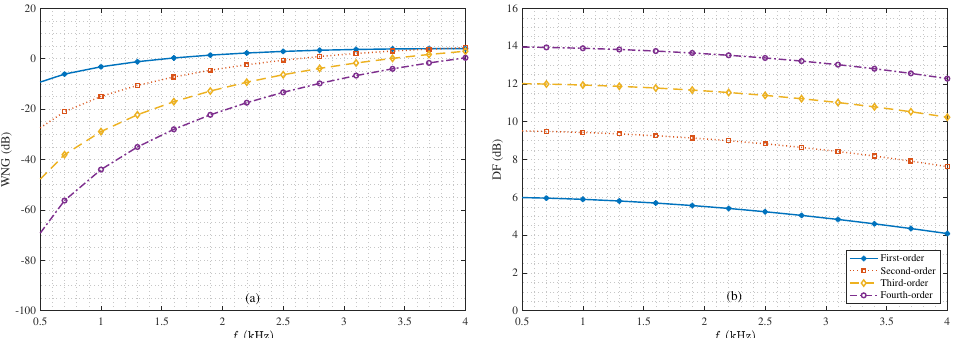
Figure 5. WNGs and DFs of the 1st-, 2nd-, 3rd-, and 4th-order binaural heterophasic superdirective beamformers versus frequency: ( a ) WNGs and ( b ) DFs. The sensor spacing: δ = 1